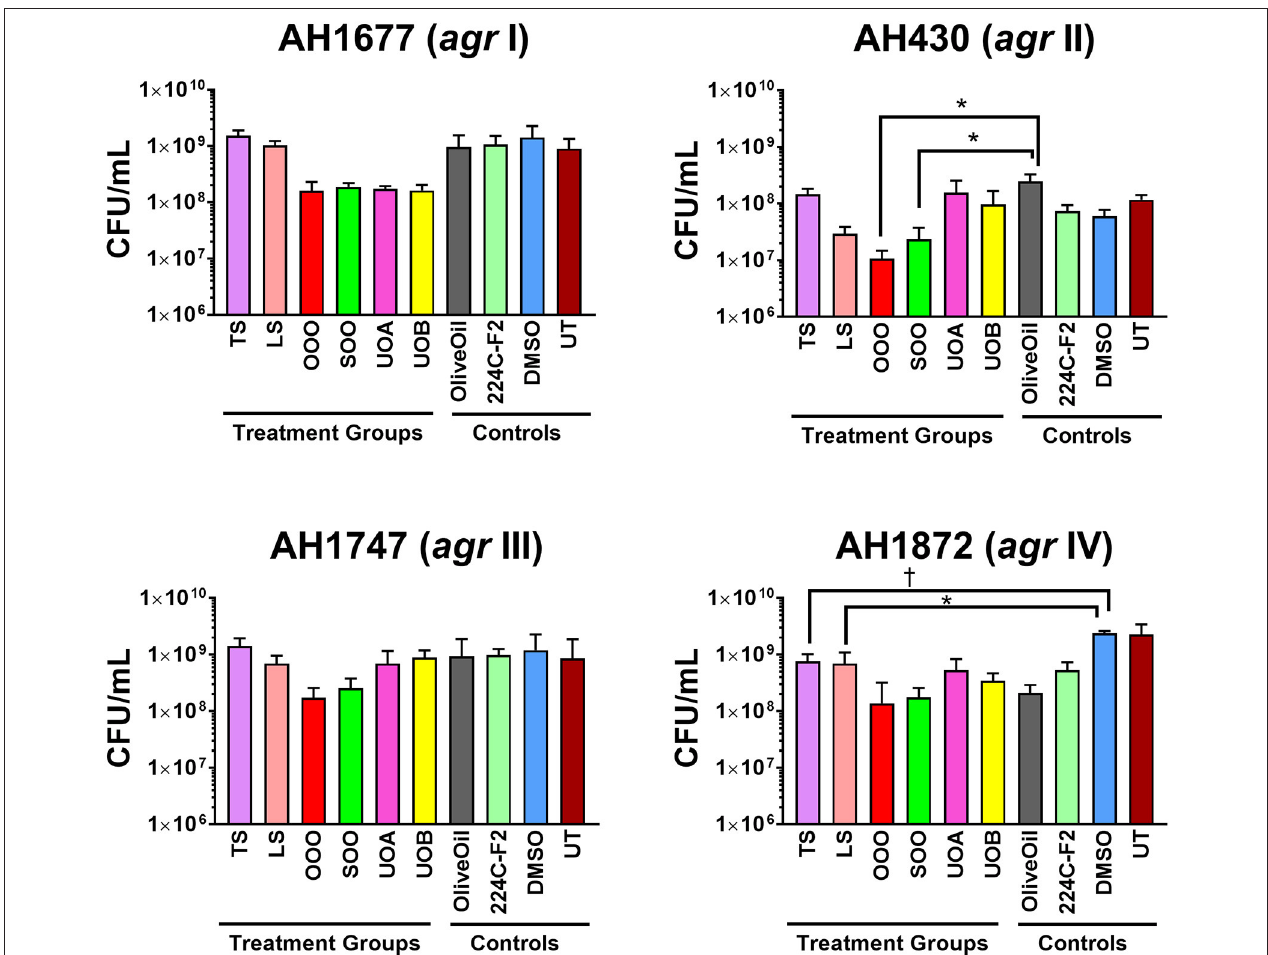
FIGURE 5 | Impact of H. perforatum commercial supplements and Oleum Hyperici samples on S. aureus growth, as determined by colony counts. To further investigate whether the decreased level of quorum sensing activity in extracts and oil macerates was due to any potential growth inhibitory effects, the number of colony forming units (CFU) per mL of broth was determined at 18 h. Test concentrations correspond to those reported in Figure 4 . Significant differences between the vehicle control and treatment groups are denoted as * P < 0.05, † P < 0.01, and ‡ P <